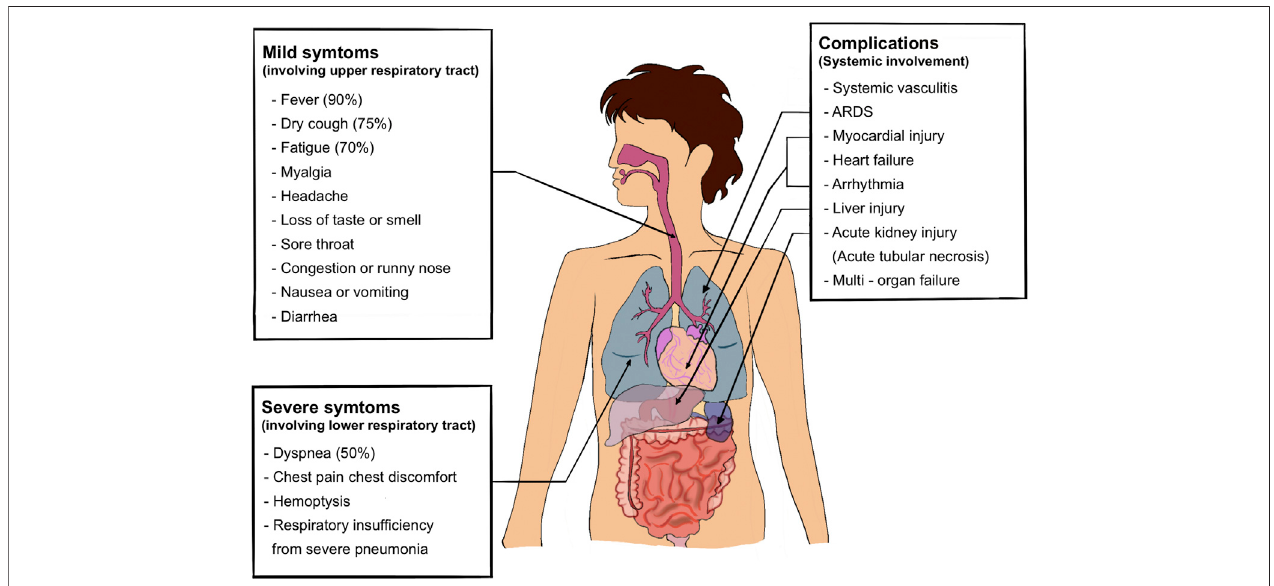
FIGURE 3 | Clinical manifestation of